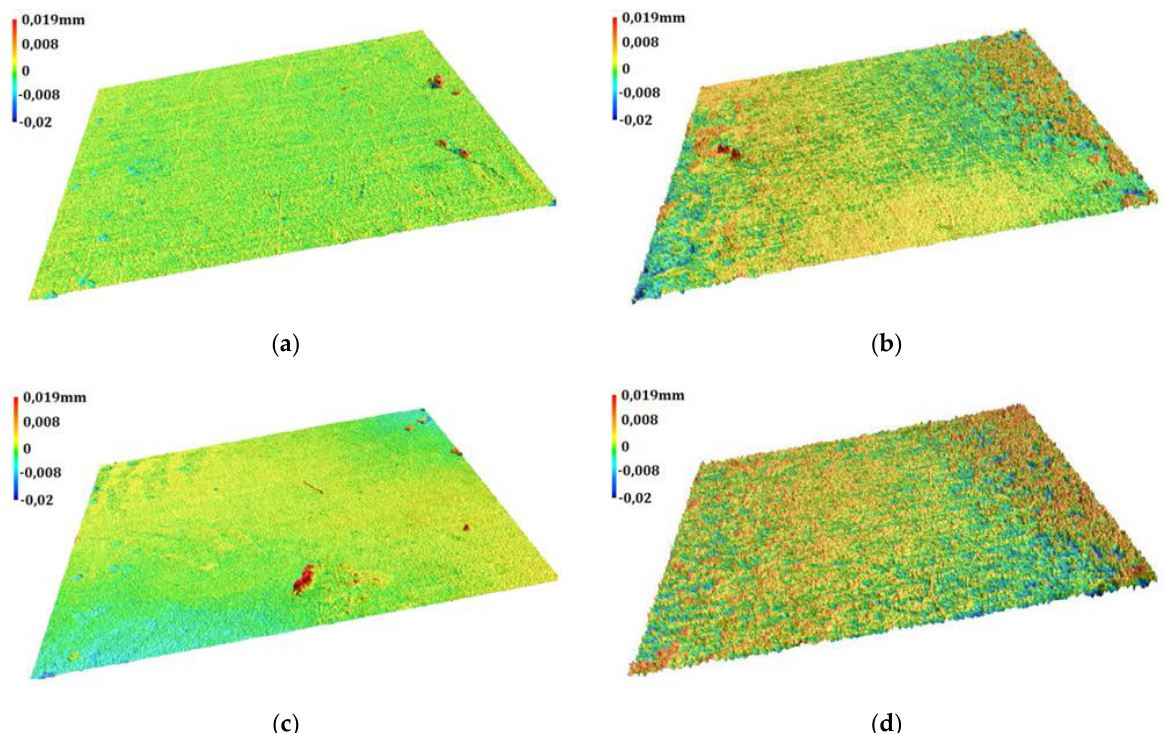
Figure 6. Axonometric projection of surface of examined layers: ( a ) Sample 1, ( b ) Sample 2, ( c ) Sample 3, ( d ) Sample 4.